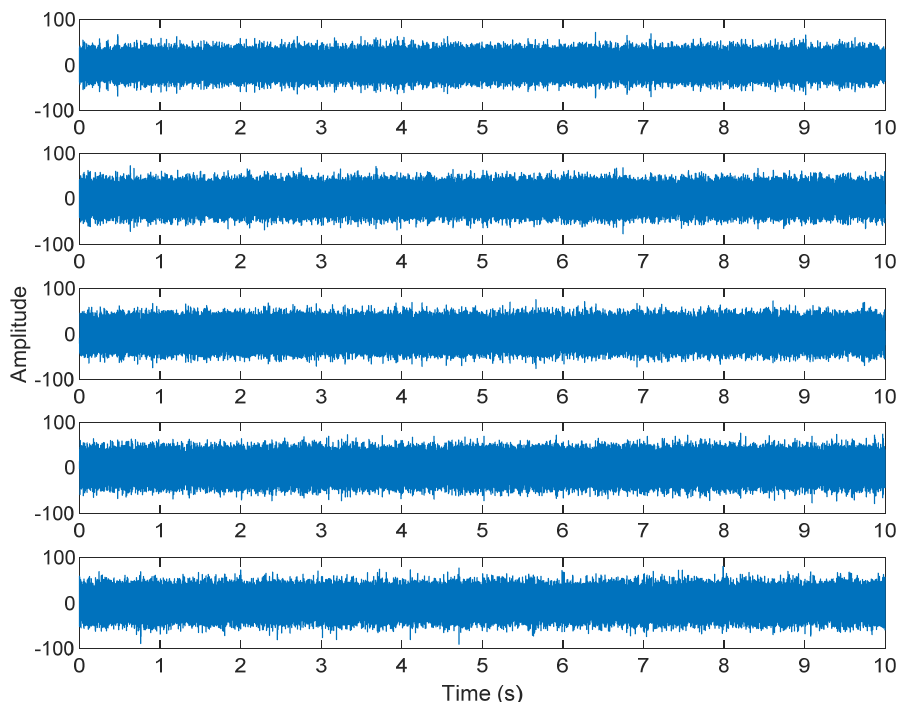
Figure 22. The results of the VMD component obtained from the numerical simulation of the sensor.